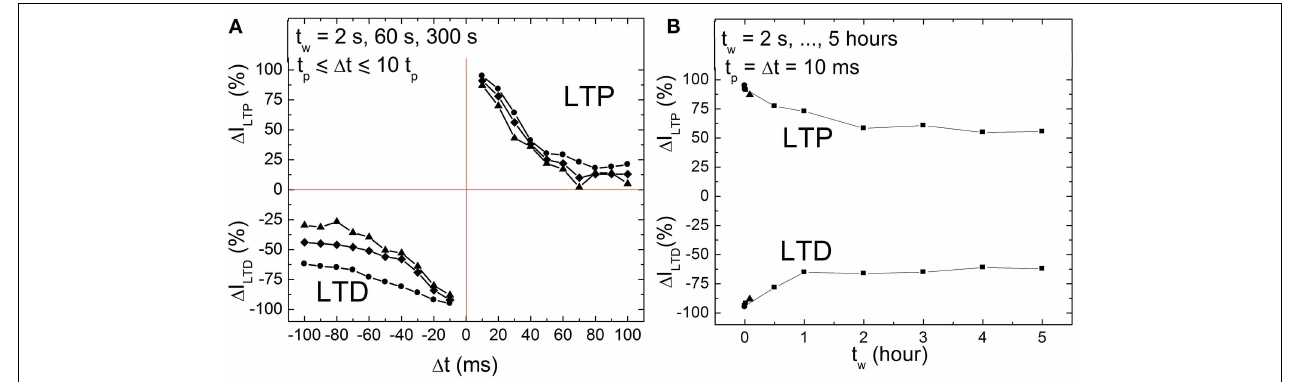
for a waiting time of t w = 2 s (circles), 60s (quadrangles), and 300s (triangles) from (A) and t w = 0 . 5 , 1, 2, 3, 4, 5h (squares). The pulse amplitude V p amounts to 3.0V. The exponential decay amounts to τ = 25 ms. The writing voltage for Memristor initialization amounts to | ± V W | = 6 . 0